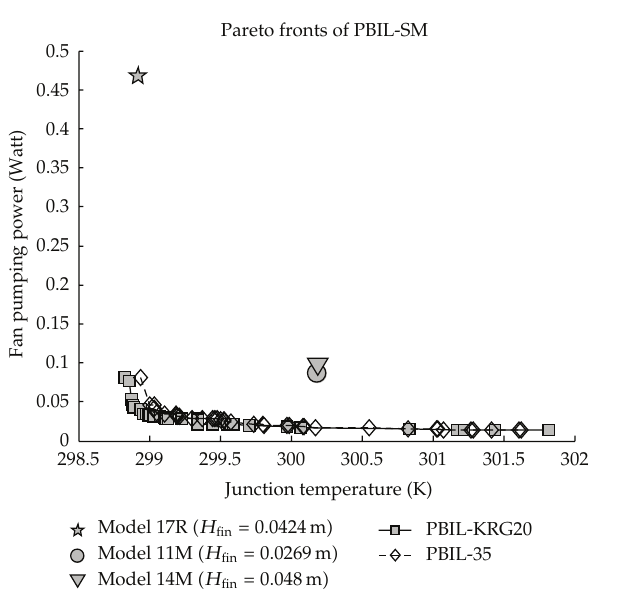
Figure 6: PBIL-KRG20 versus